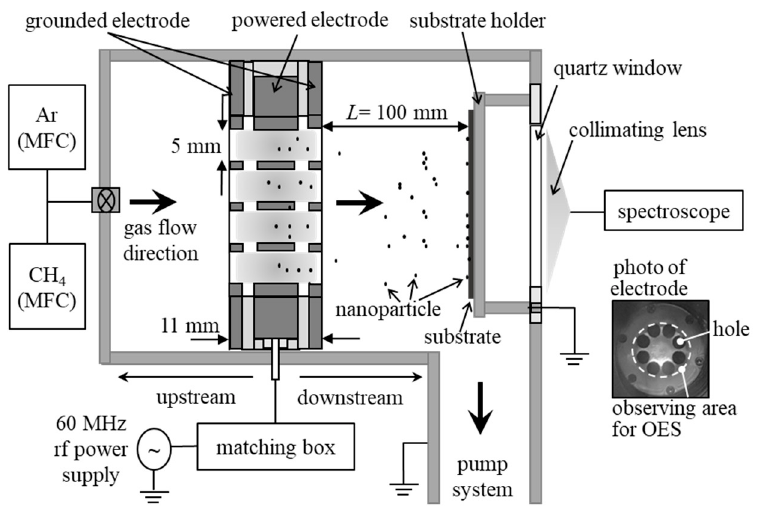
Figure 1. Multi-hollow discharge plasma.